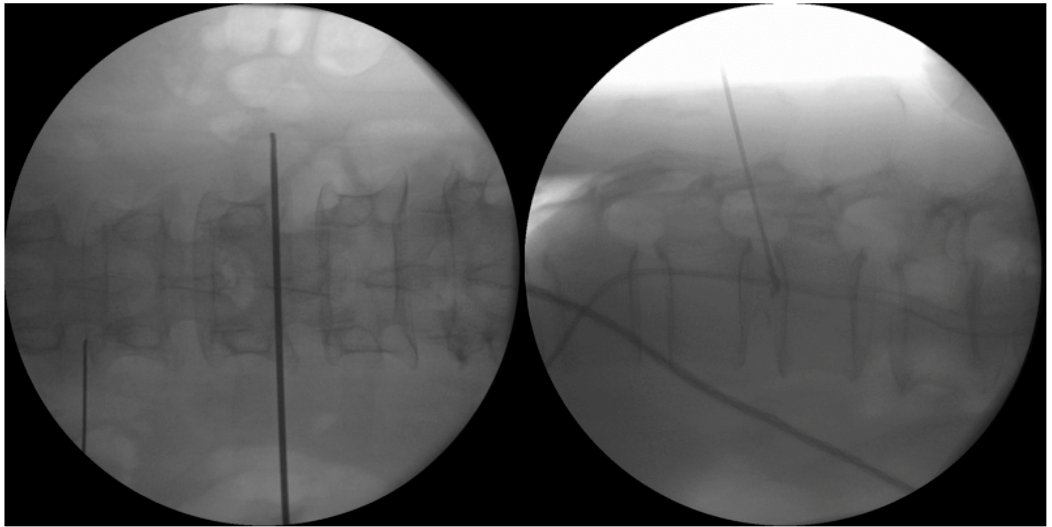
Figure 4. Provocative discogram at L1/2. The left picture shows the landmark of the Antero Posterior view of the L1/2 disc entry point. The right picture shows the lateral view with provocative discogram, the patient had immediate axial back pain and left buttock pain which is similar in nature to her chronic back pain.